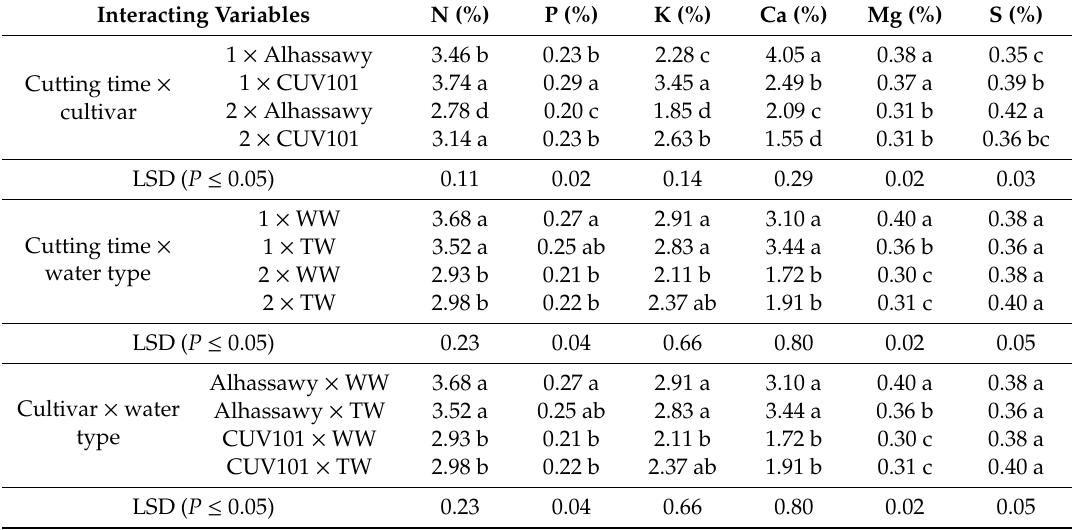
E ff ects of the interactions between each pair of independent variables on alfalfa macronutrient